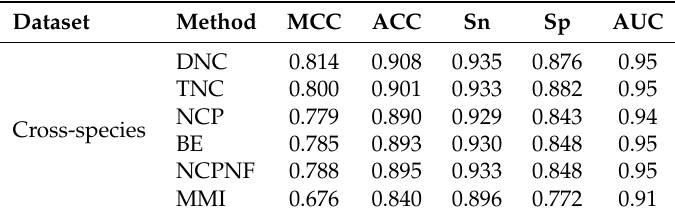
Figure 4. Grapical demonstration of performance comparison between six encoding methods on the training cross-species dataset. Table 5. Performance evaluation of six encoding methods on training benchmark dataset for